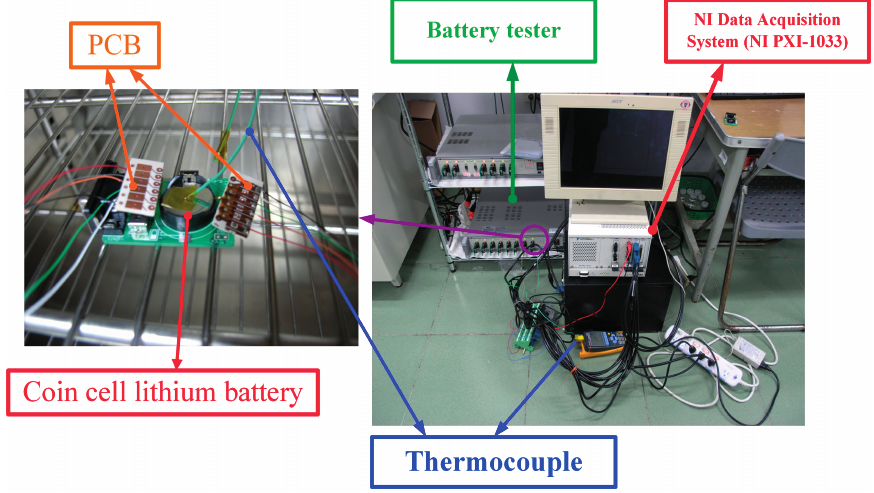
Figure 7. Coin cell test assembly and instrument mounting.